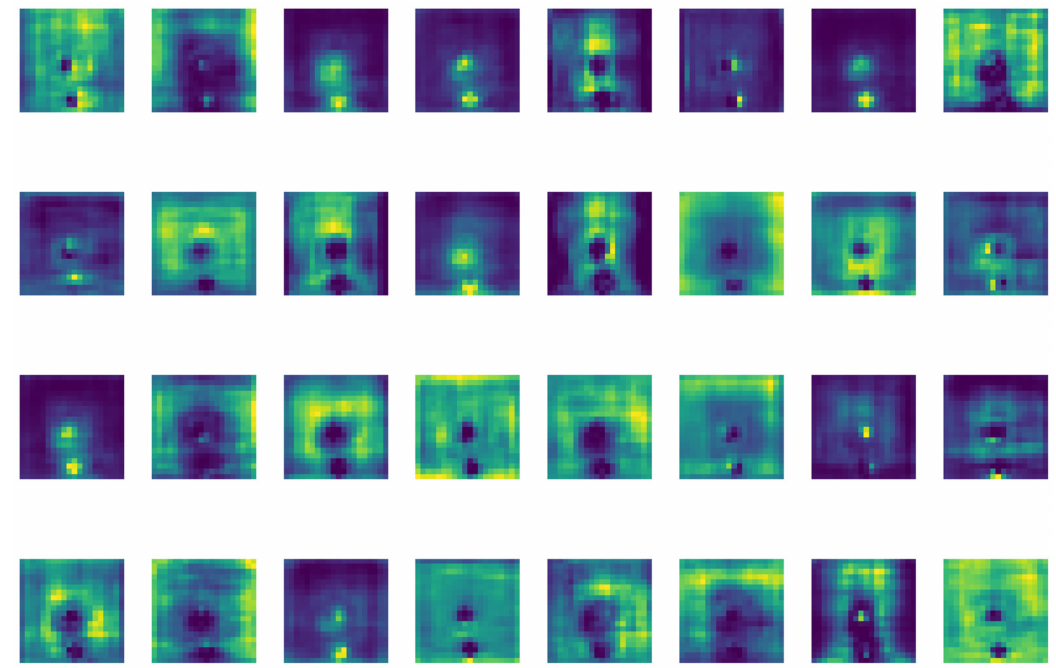
Figure 16. Visualization of the weighted boxes fusion